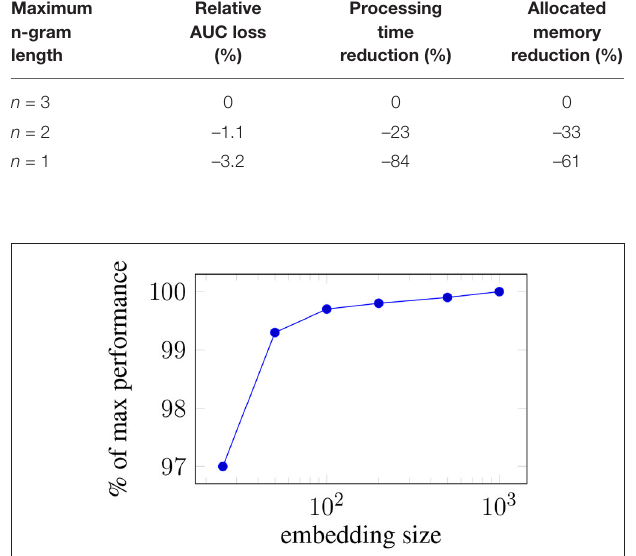
FIGURE 3 | Ablating: Average performance loss across all the targets when the embeddings size is reduced.